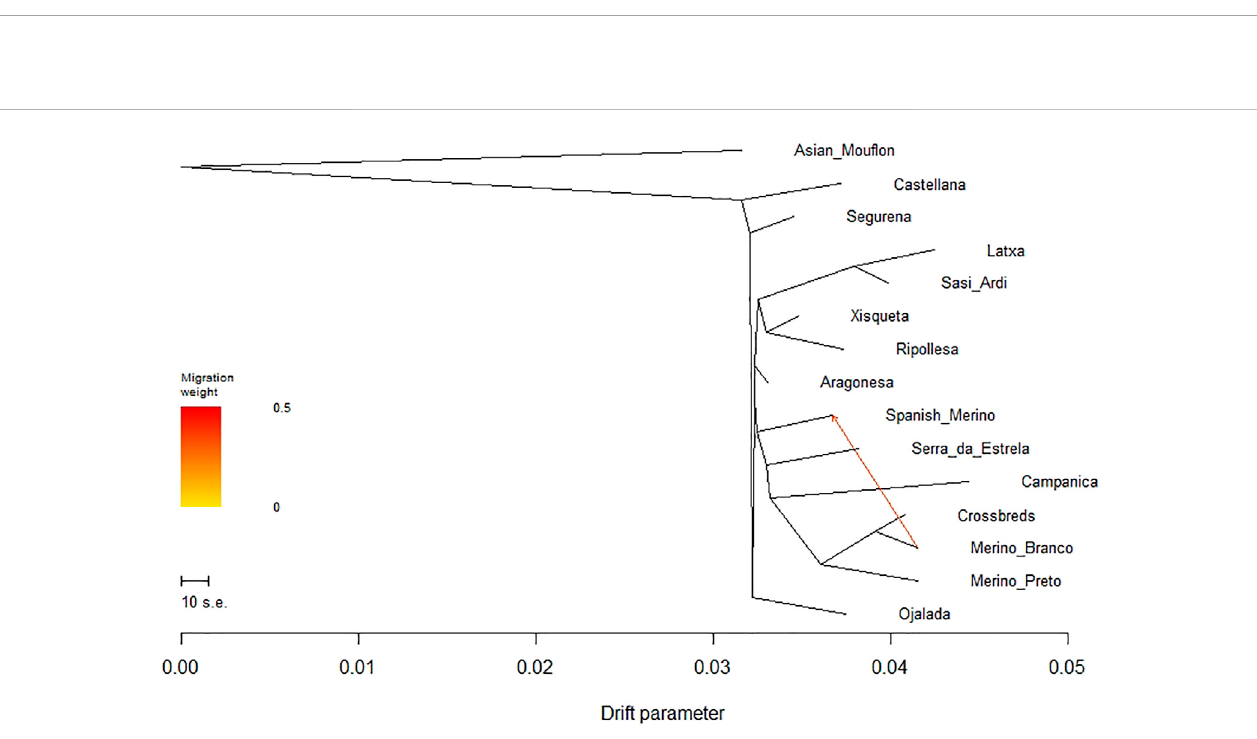
FIGURE 8 Maximum-Likelihood phylogeny of sheep mitogenomes. Portuguese native sheep (light grey) belong to haplogroup B1a and three crossbred animals clustered within haplogroup A1a. Reference sequences representing major haplogroups are colored as follows: (A) (dark blue); (B) (red); (C) (dark green); (D) (purple); (E) (yellow). Wildsheepmitogenomeswerealso includedintheanalysis: Ovismusimon (withinhaplogroup A); Ovisvignei (pink); Ovis ammon (petrol blue). See Supplementary Table S4 for details on each individual included in the analysis.